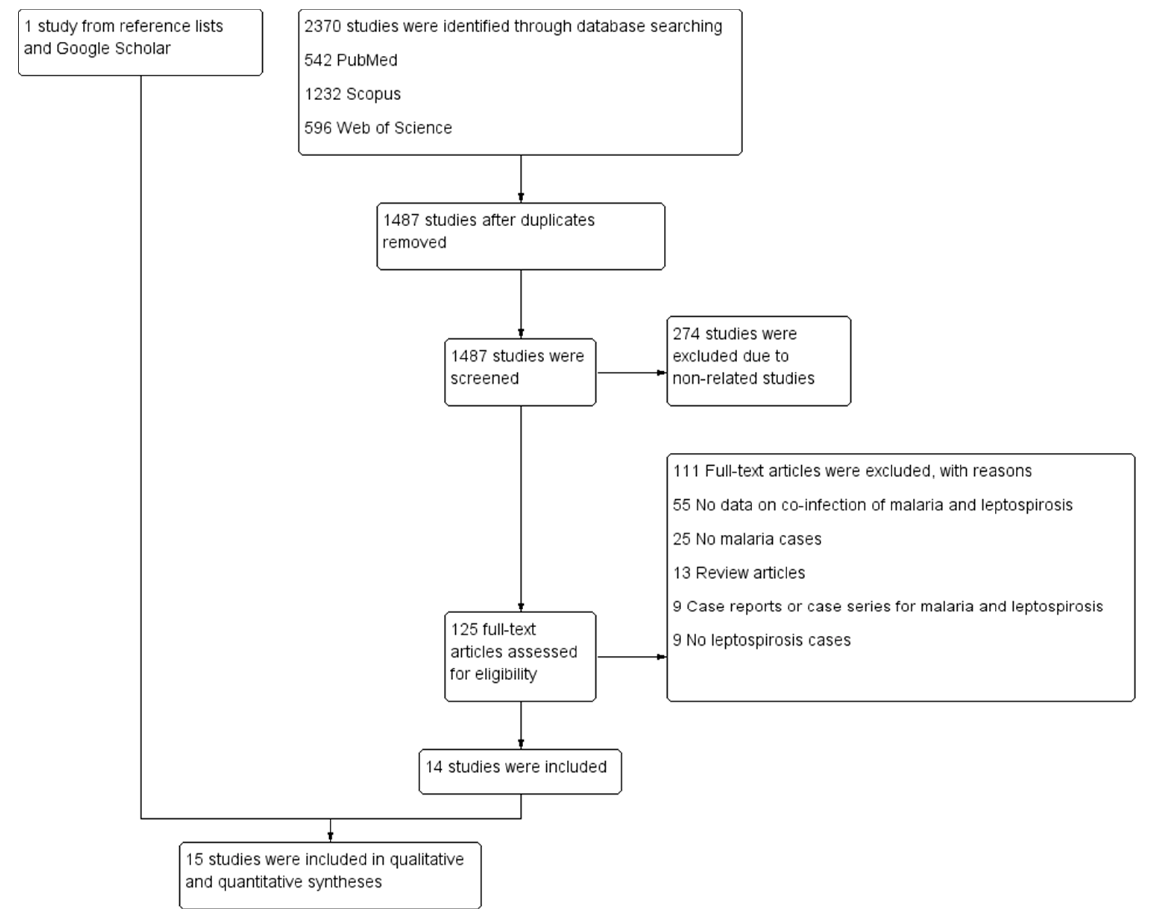
Figure 1. Study flow diagram. Study selection process